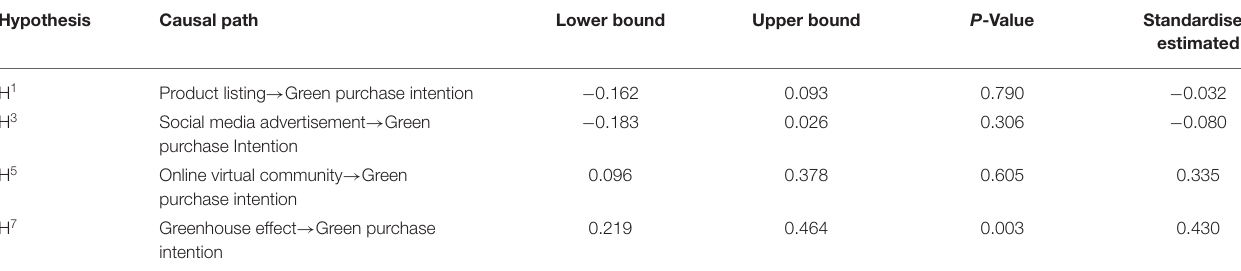
TABLE 6 | Results of the structural model: direct effects (H 1 , H 3 , H 5 , and H 7 ). Hypothesis